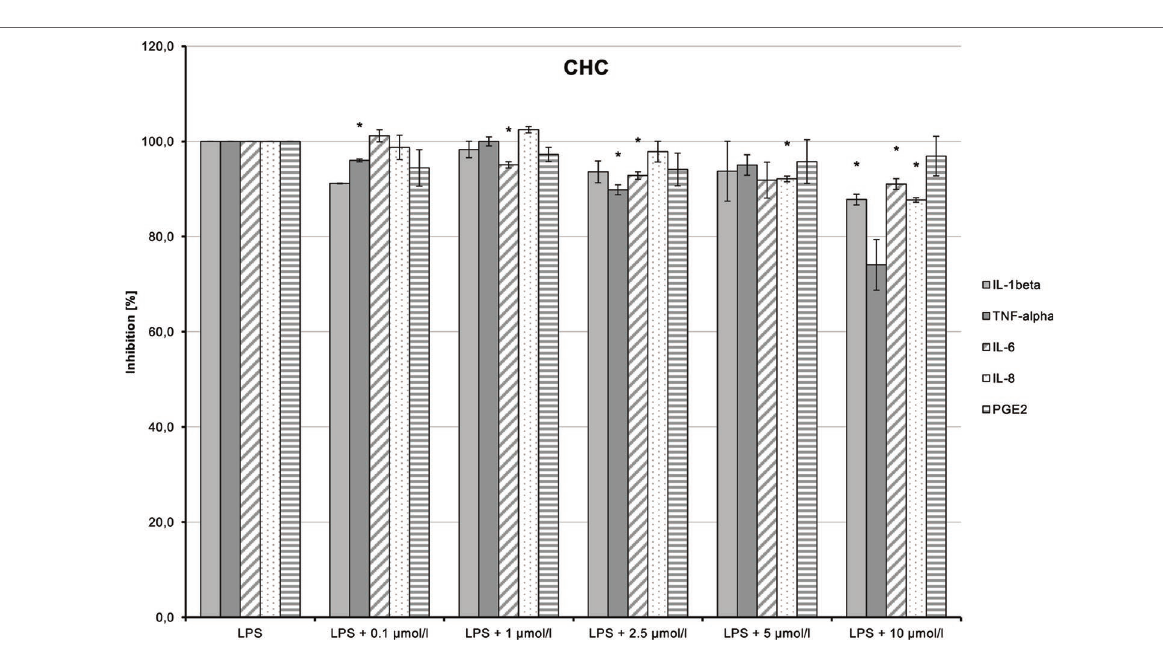
Frontiers in Pharmacology |